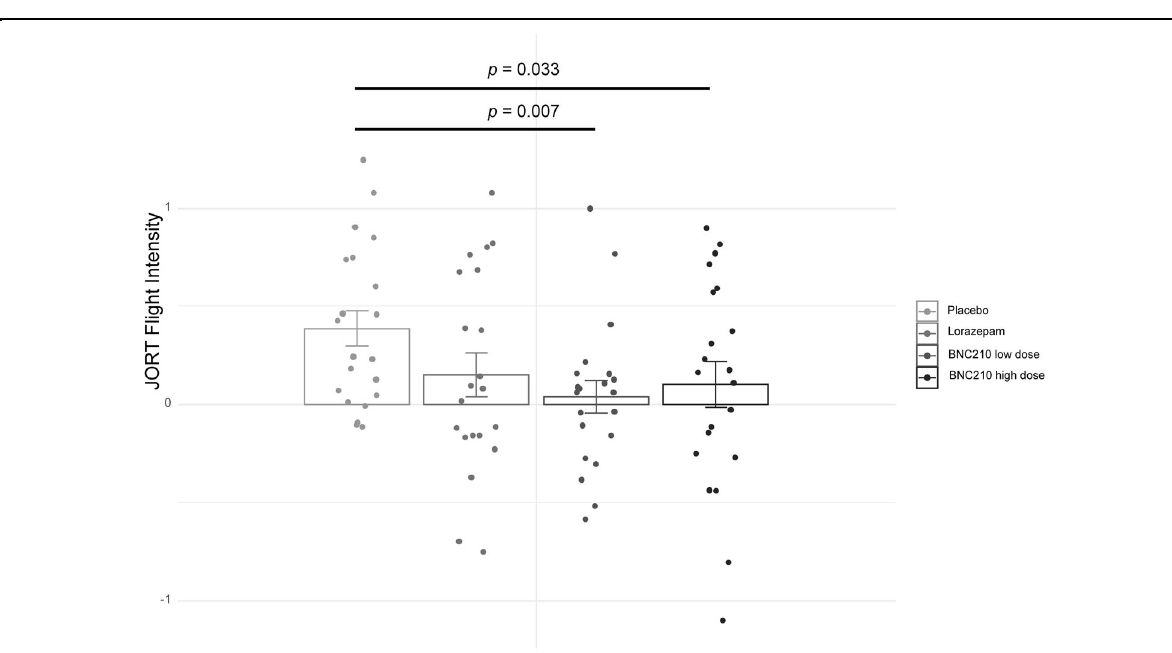
Fig. 4 Drug effects on Flight Intensity as measured by the Joystick Operated Runway Task (JORT). Flight Intensity was signi fi cantly decreased by both low and high doses of BNC210 but not by lorazepam ( n = 21, error bars = 1